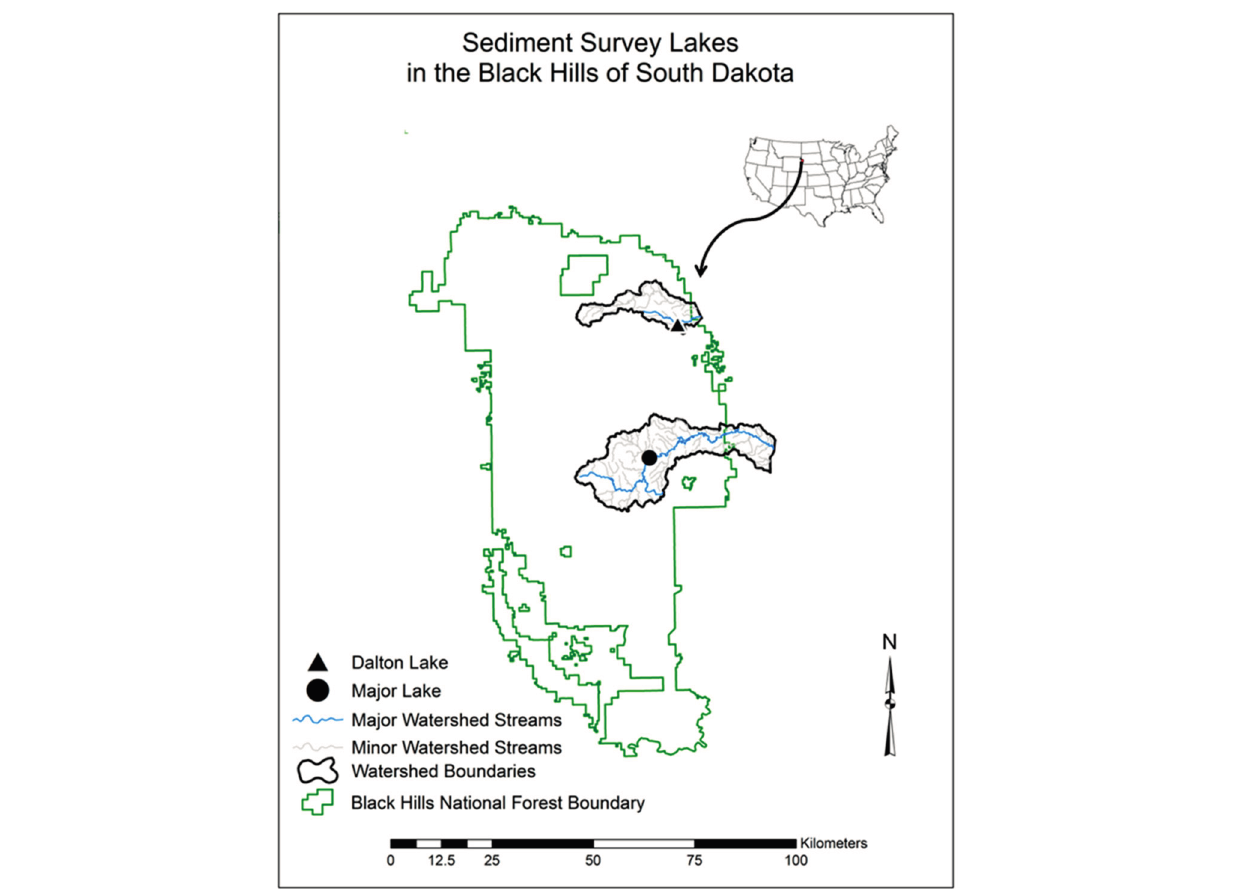
Figure 2. Map of sample area in the Black Hills of South Dakota. Triangle is the location within the Elk Creek Watershed where Dalton Lake is located. The circle is the location where Major Lake is located within the Spring Creek